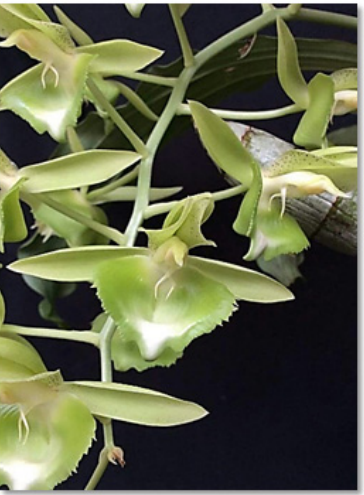
Figure 1. Catasetum alatum. (Source Luiz Otavio Ad ã o). Geographic distribution: Endemic in Brazil. Occurrence for the North region of Brazil, State of Rond ô nia, in riparian or gallery forest areas [17]. Table 1. Constituents identified in the volatile concentrate of C. alatum flowers.